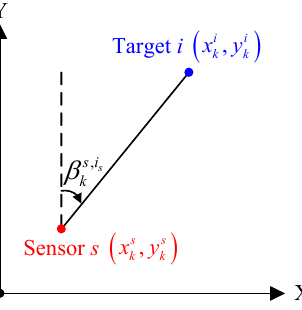
Figure 1. Illustration of two-dimensional bearing